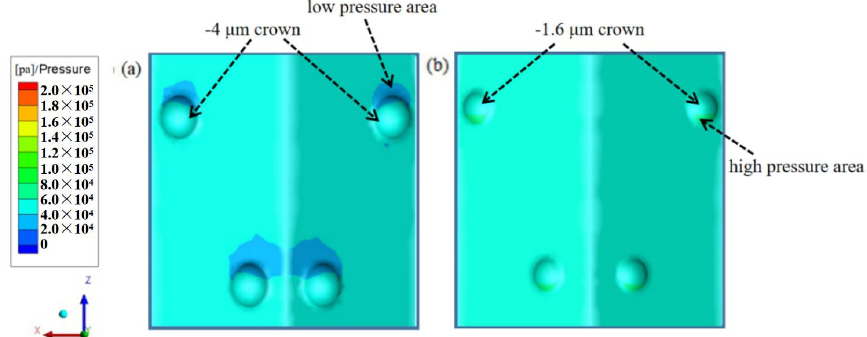
Figure 14. From ( a – e ) the longitudinal height of the negative crown is arranged in order from deep to shallow. It can be seen that as the longitudinal height decreases, the size of vortexes in the crown gradually decreases. Surface drag reduction.